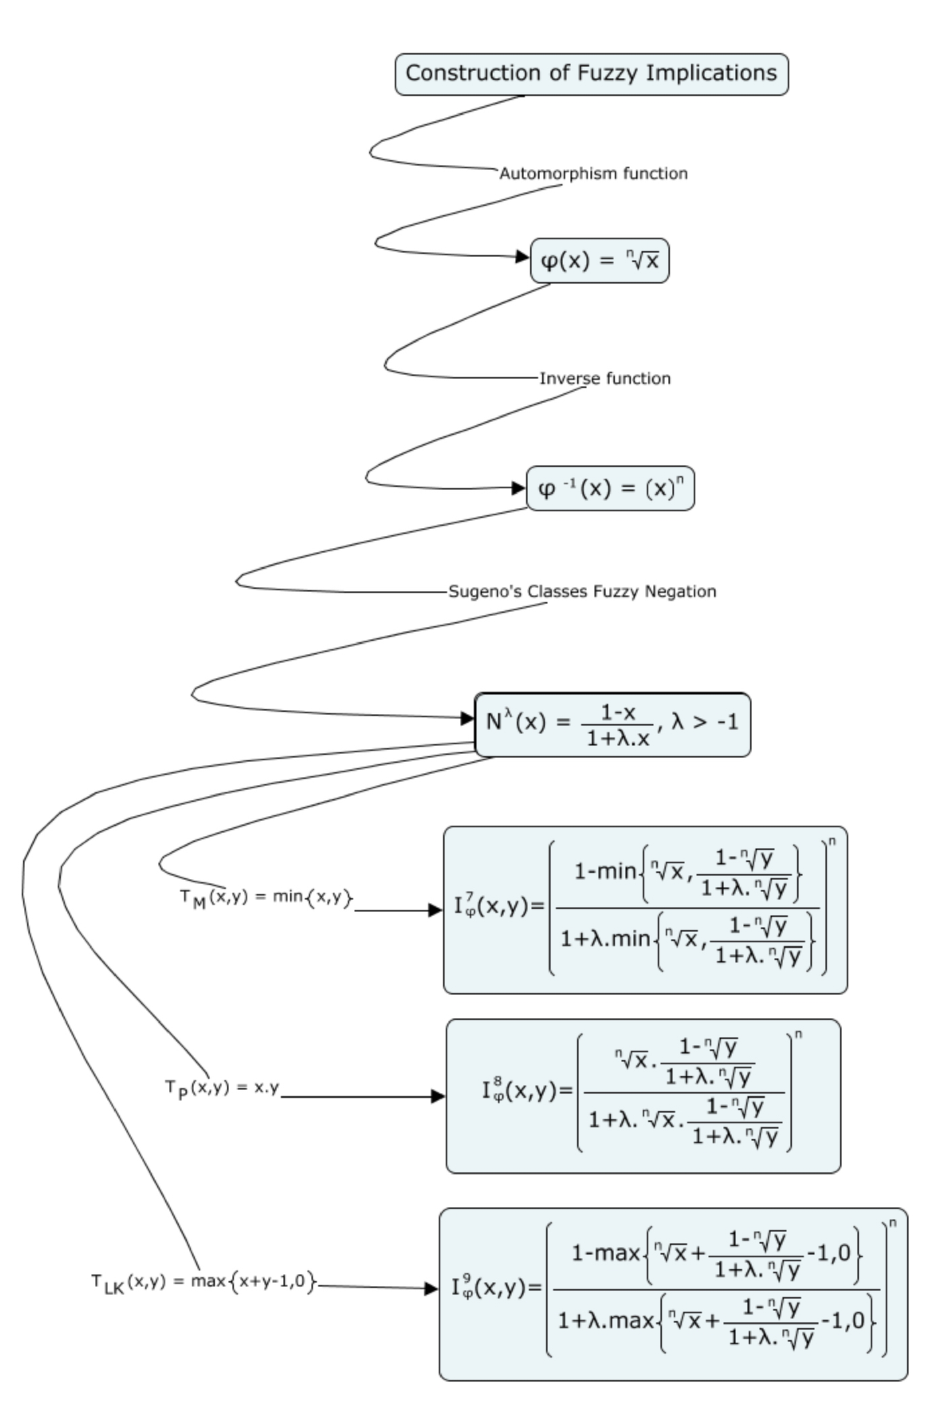
√ x , N λ ( x ) = 1 − x 1 + λ x